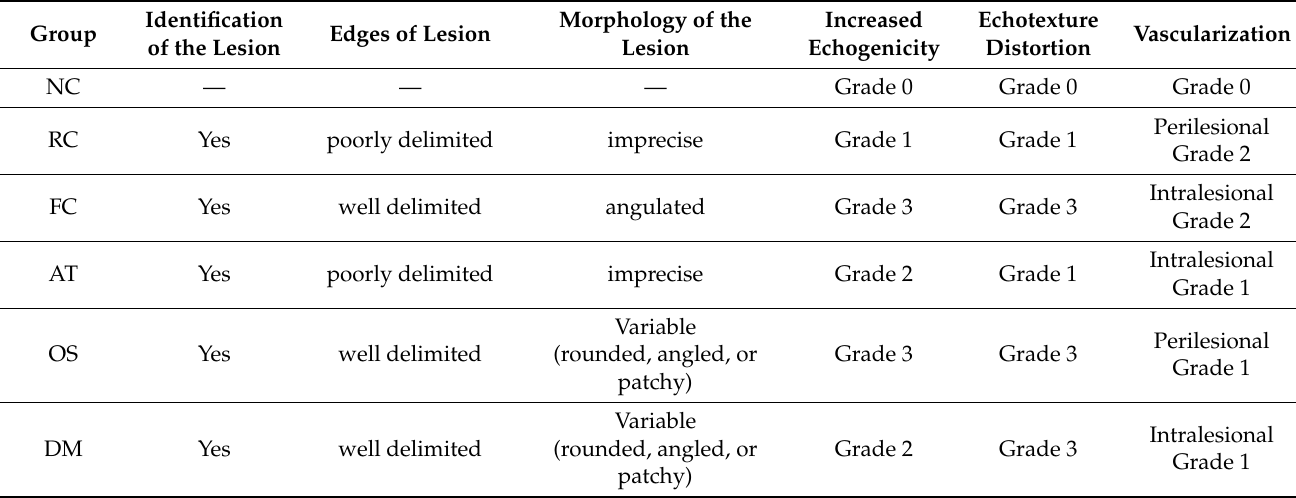
Table 1. Summary of the ultrasound findings in the implantation area of the VML lesion with the tissue/biomaterial used after 60 days of evolution.